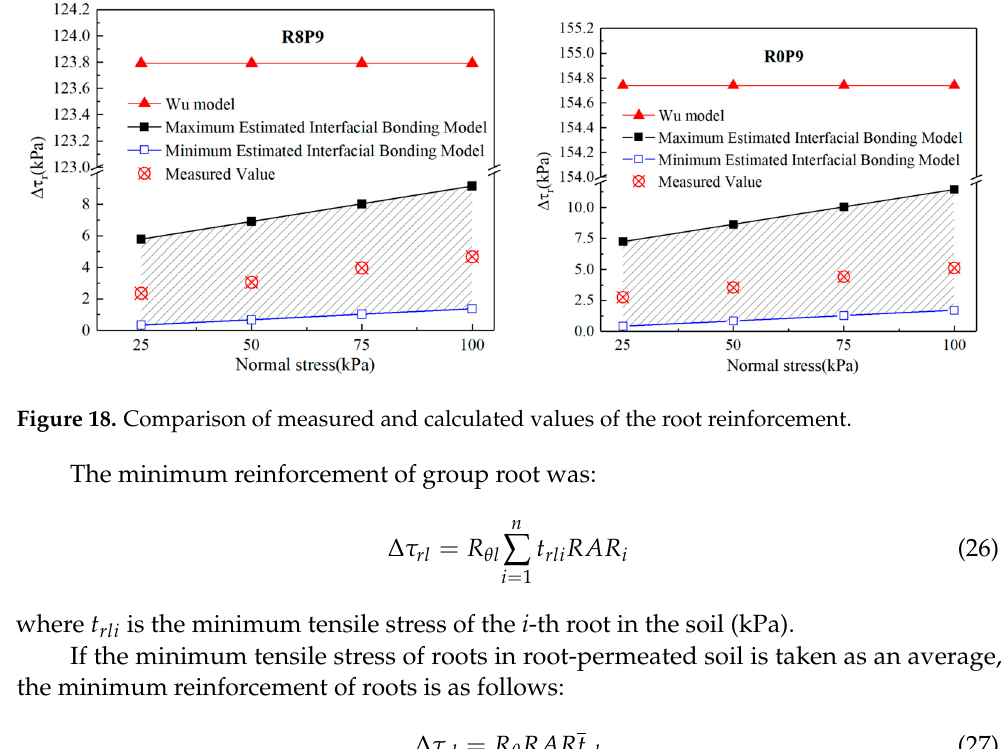
Table 8. Model calculation parameters of shear strength of root-permeated